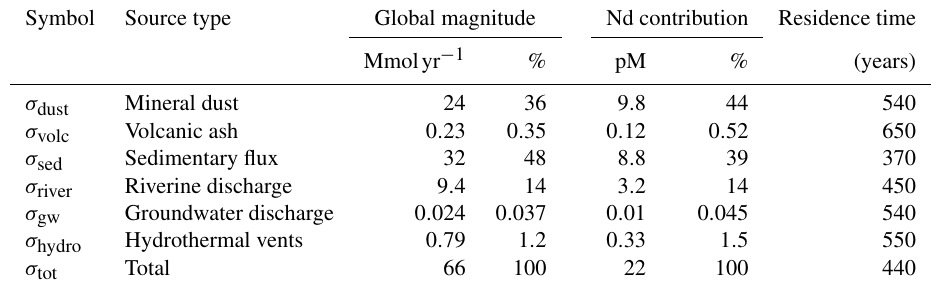
Figure 10. (a) GEOTRACES cruise tracks with ε Nd observations. The legend layout matches the layout of the other subplots of the figure. (b–j) Modeled and observed ε Nd along GEOTRACES transects. Modeled values are shown as filled contours, while observed values are overlaid as a scatterplot. Table 3. Source magnitudes, their Nd contributions, and corresponding bulk residence time. Values are reported with two significant digits. Symbol Source